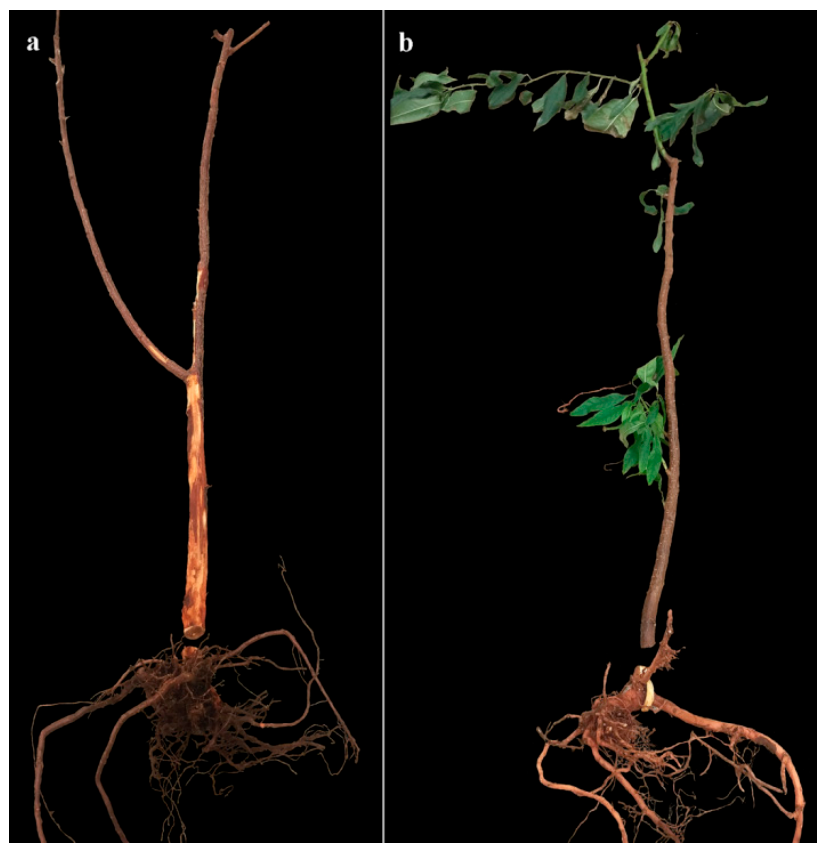
Figure 4. Inspected 2729 ( a ) and GF677 ( b ) rootstocks from control treatment at the end of the 2019 ( a ).